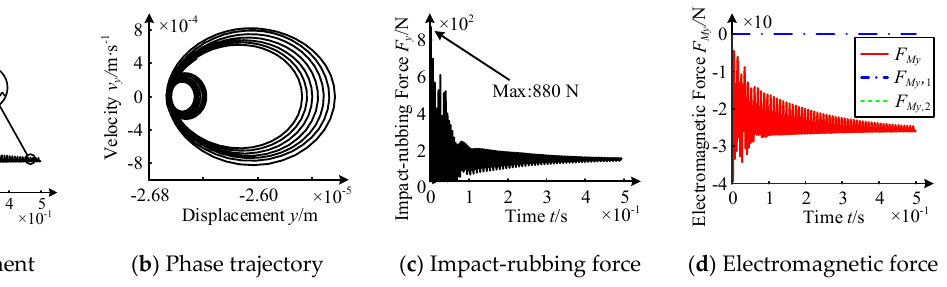
into the bouncing stage and eddy stage, when the upper unit fails. When the rotor falls directly on the fixed ring, it firstly bounces and collides and then vortexes repeatedly In order to further analyze the bounce-eddy situation of the rotor falling, the rotor displacement, phase trajectory, rubbing force, and electromagnetic force were extracted, as shown in Figure 9.